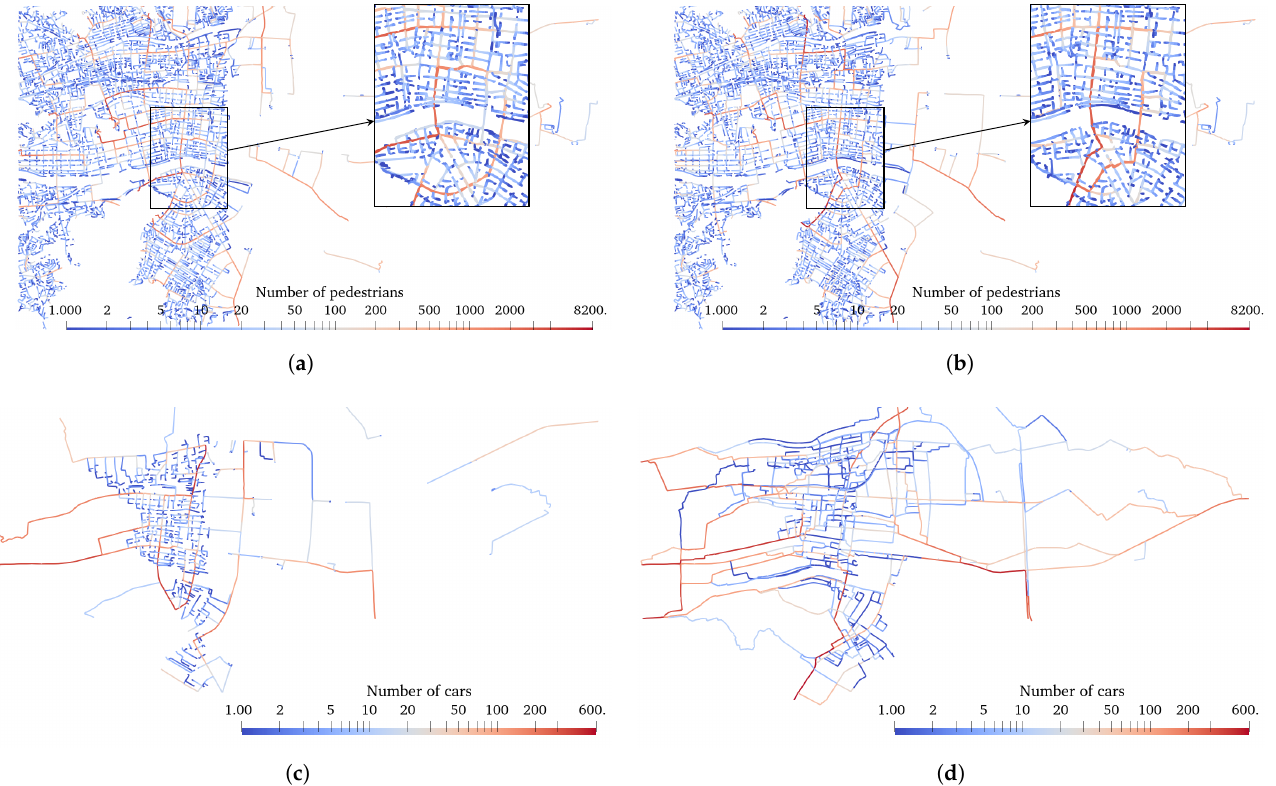
Figure 13. Routes taken by pedestrians and cars for the last two scenarios with 15% car users: ( a ) Pedestrians (15% car users), ( b ) Pedestrians (15% car users+route restrictions), ( c ) Cars (15% car users), ( d ) Cars (15% car users+route